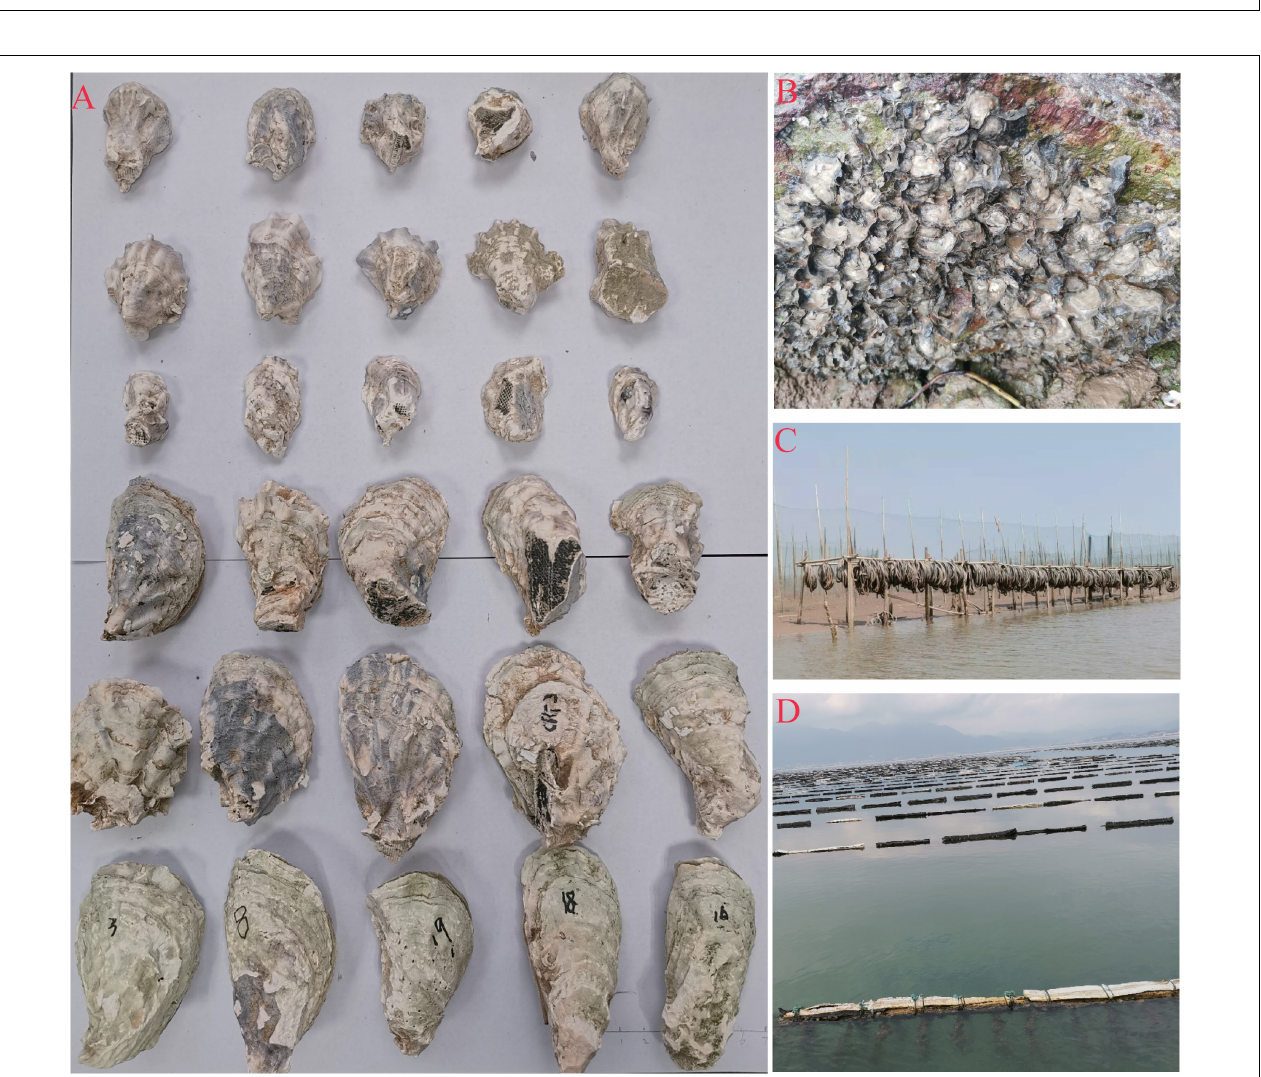
FIGURE 2 | Oyster samples and their habitat. (A) Line 1–3 are cultured Kumamoto oyster sampled in Sanmen bay, Xiangshan bay and Yueqing bay, respectively, line 4 are Portuguese oyster sampled in the Xiangshan bay, line 5 are cultured Portuguese oysters originate of artificial breeding spat from Fujian province and line 6 are adult Portuguese oysters from Fujian province. (B) Oysters grown in the muddy intertidal zone. (C) Oyster seedling collection facilities using the abandoned bicycle tires as attachment in the intertidal zone. (D) The longline cultured oyster facilities in the local area hanging the abandoned bicycle tires directly.